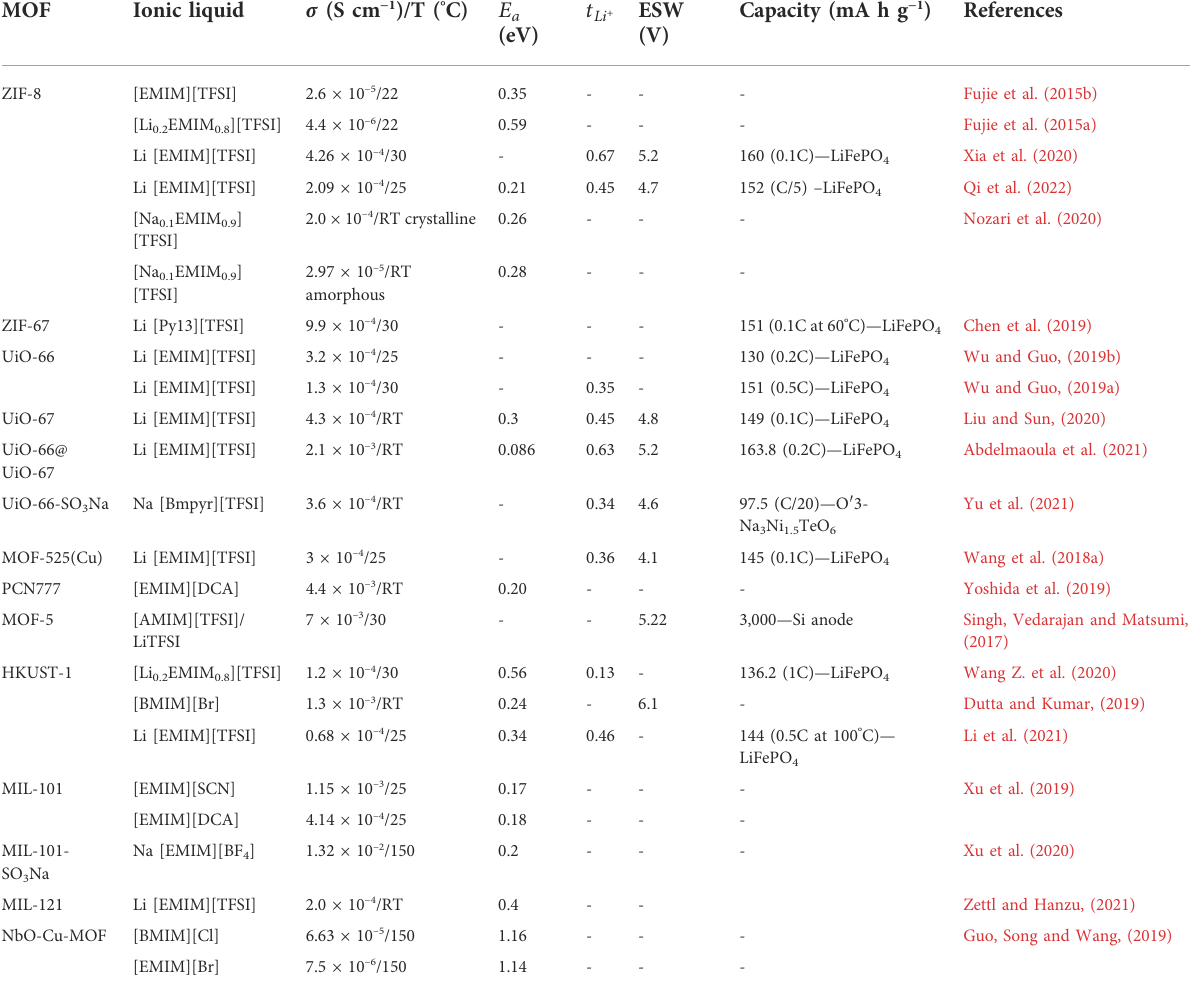
TABLE 1 Summary for IL@MOF based electrolytes.